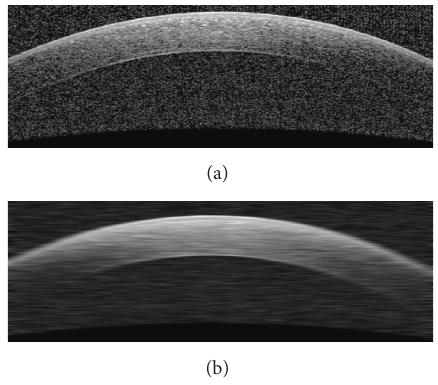
Figure 3: (a) Original image. (b) Denoised image using a Gaussian kernel [ 1 × 30 ] (std of